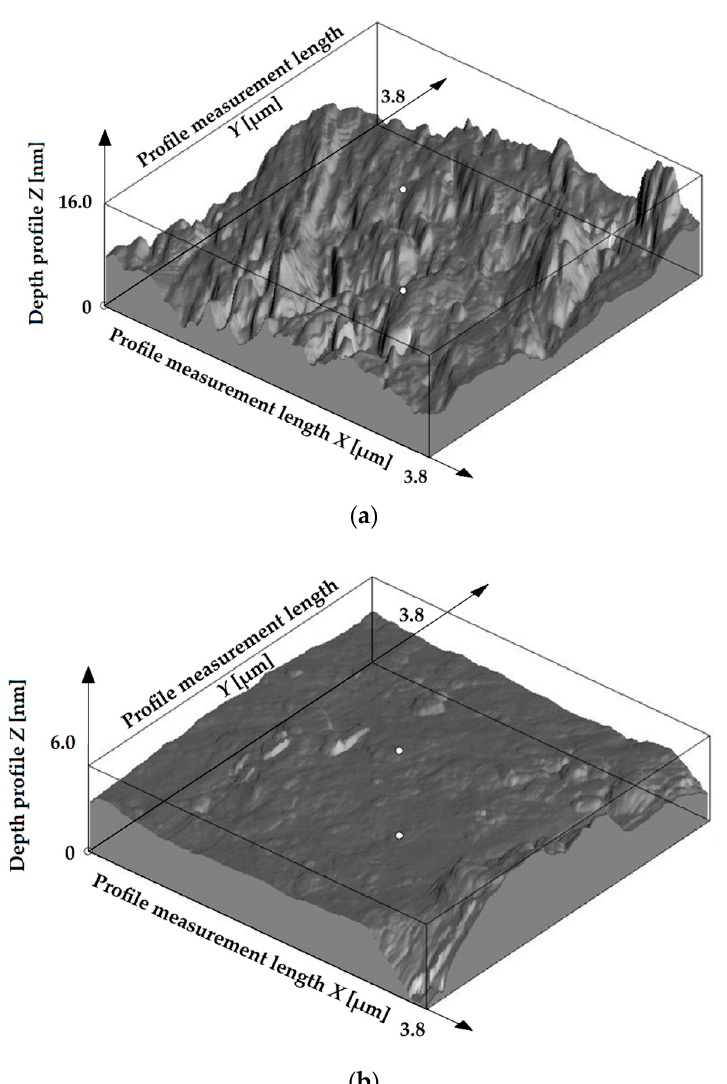
Figure 7. Surface topology of the samples (atomic force microscopy): ( a ) after production; ( b ) after cavitation-abrasive finishing.